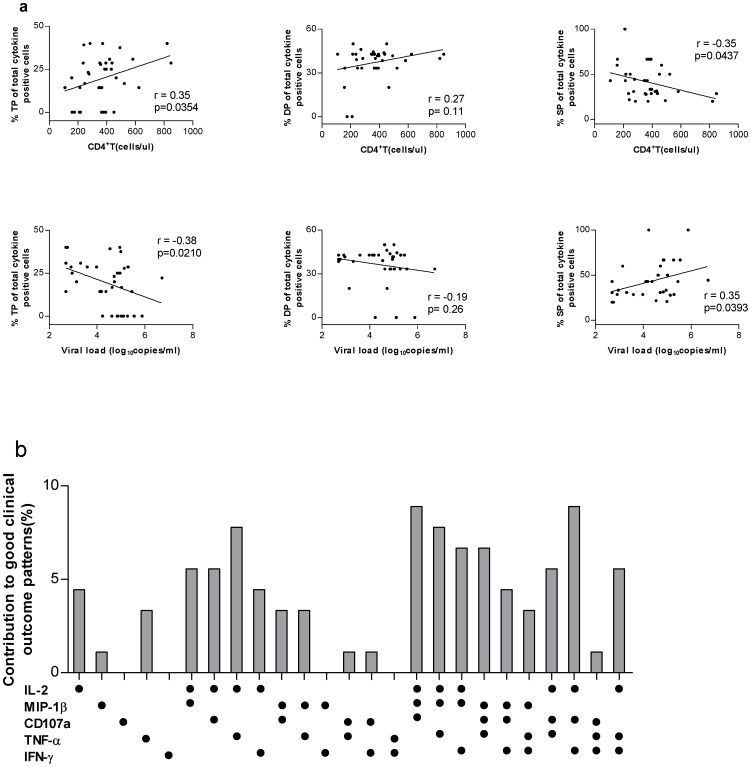
Correlations between CD8+ T-cell functionalities and blood CD4+ T-cell counts or plasma viral loads during early chronic HIV-1 infections.a. Correlation between the CD8+ T-cell functionalities and blood CD4+T-cell counts or plasma viral load for triple producers (TP), double producers (DP), and single producers (SP) of Gag2-specific responses in early chronic HIV-1-infected individuals. b. Different functional HIV-specific CD8+ T cells associated with good clinical outcomes (good clinical outcomes indicated an inverse correlation between the magnitude of HIV-specific CD8+ T-cell responses and viral loads, or a positive correlation between the magnitude of HIV-specific CD8+ T-cell responses and CD4+ T-cell counts). Results from linear regression model analysis on the magnitude of eight HIV-peptide pool specific responses against blood CD4+ T-cell counts or plasma viral loads during early chronic HIV-1 infections. Each dot denoted a positive response for the function indicated at the bottom left.